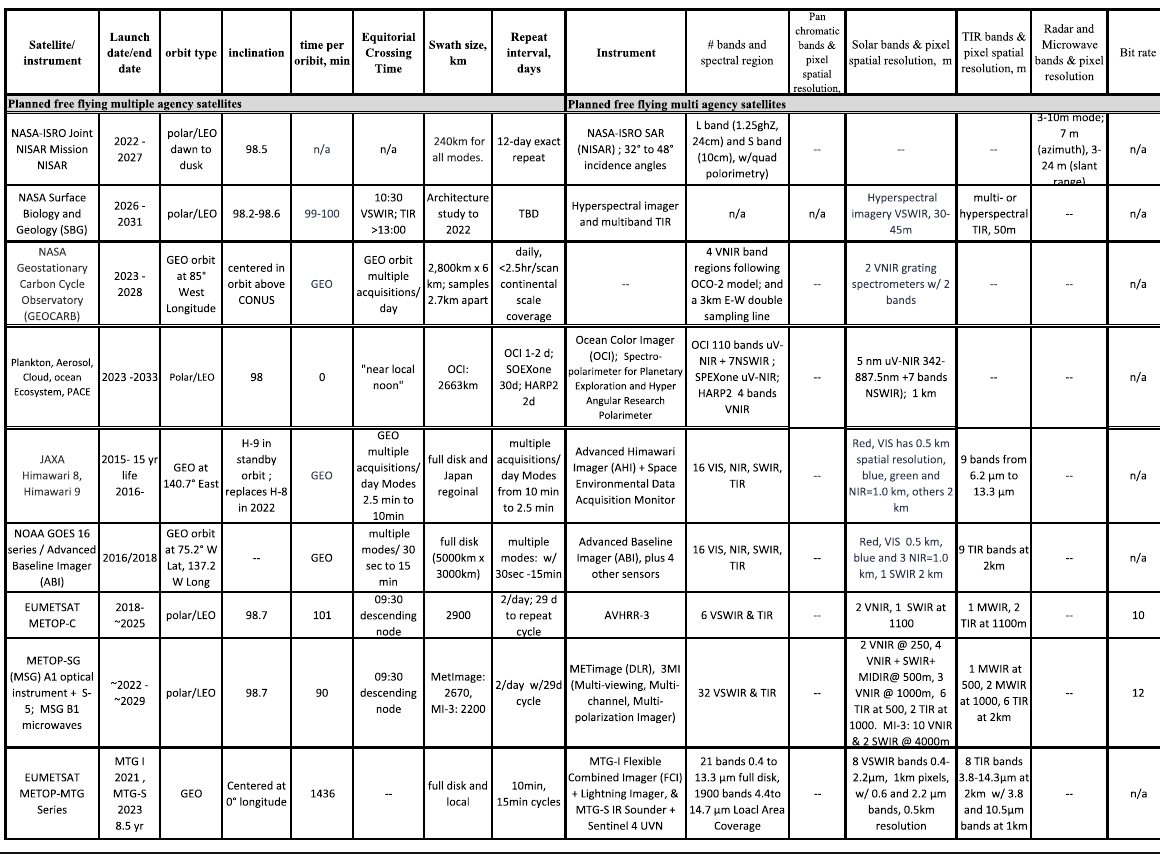
Table 5 Planned free-flying satellites from multiple